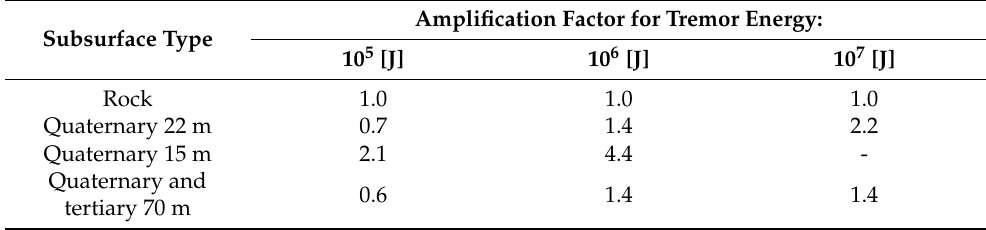
Table 1. Amplification factor depending on the tremor’s energy and subsurface soil type and thickness.